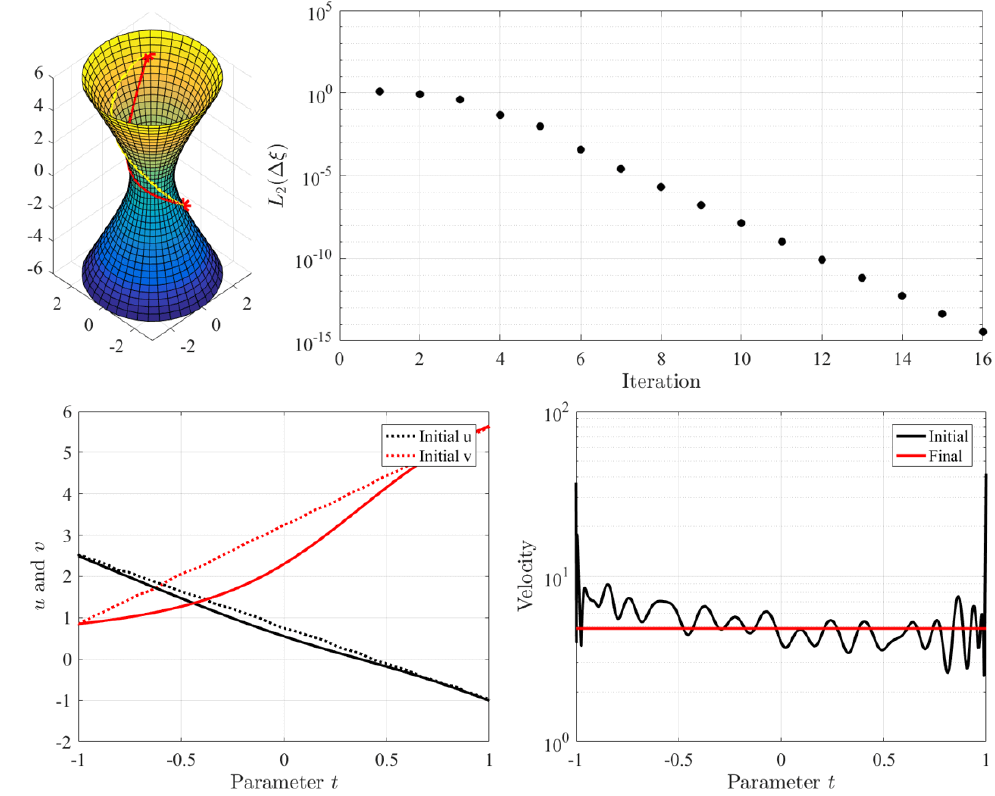
Figure 7. One-sheeted hyperboloid test